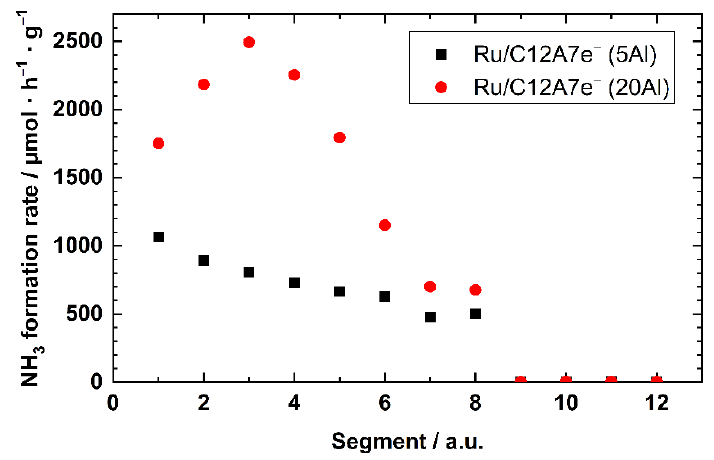
Figure 3. NH 3 formation rate of two different plasma-synthesized 1.2 wt.% Ru/C12A7e − catalysts in ammonia synthesis, black (g) Ru/C12A7e − (5Al) and red (h) Ru/C12A7e − (20Al). The testing conditions for each segment are summarized in Table 2.